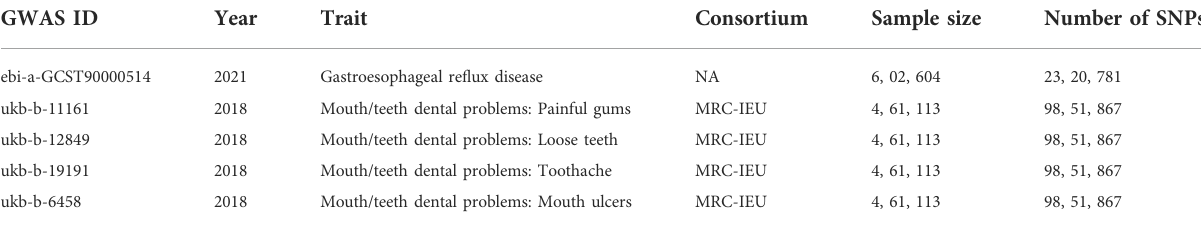
TABLE 1 Basic information on the GWAS applied in this study. GWAS ID